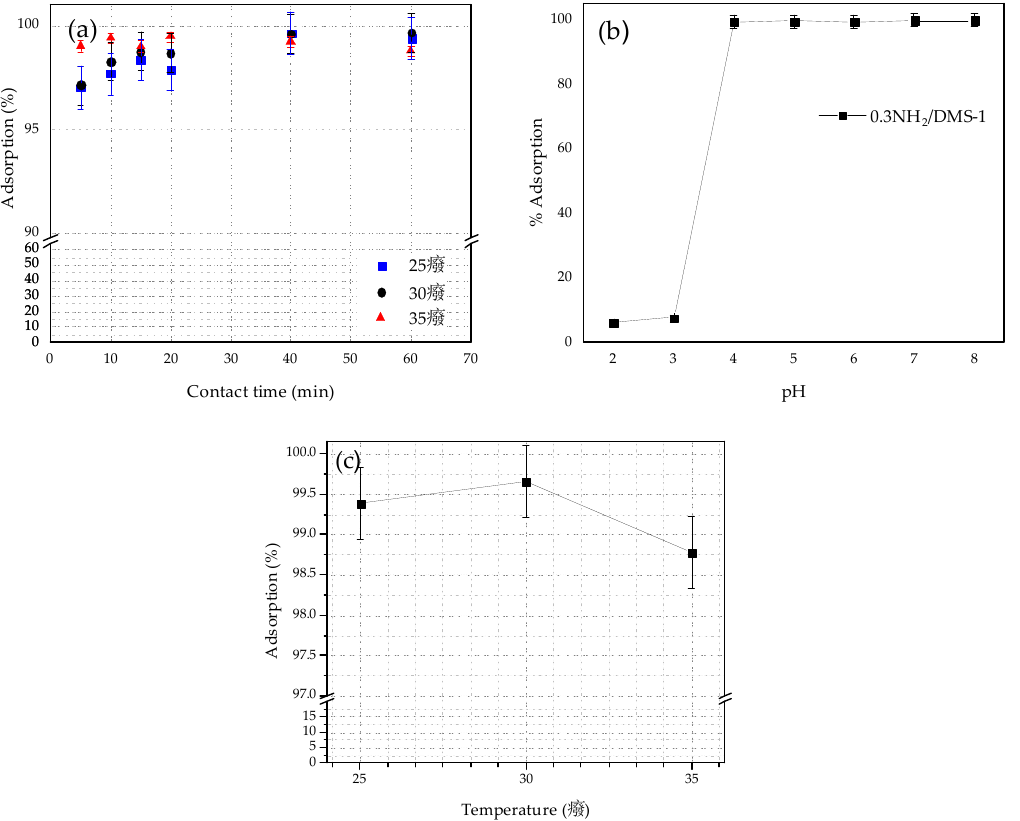
Figure 7. The e ff ect on the Pb(II) ions adsorption onto 0.3NH 2 / DMS-1 of: ( a ) Contact time from 5 to 60 min at pH 5 and 25, 30 and 35 °C, ( b ) pH ranging from 2 to 8, at 30 °C for 60 min, and ( c ) Temperature at pH 5 for 60 min. Conditions: 20 mL of 100 ppm of Pb(II) ions solution, 0.10 g of adsorbent